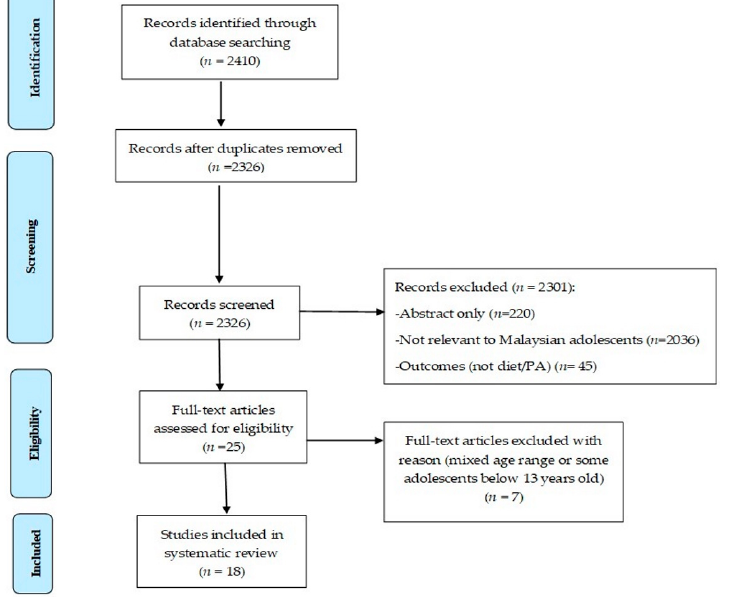
Figure 1. PRISMA Flow Diagram of study selection.